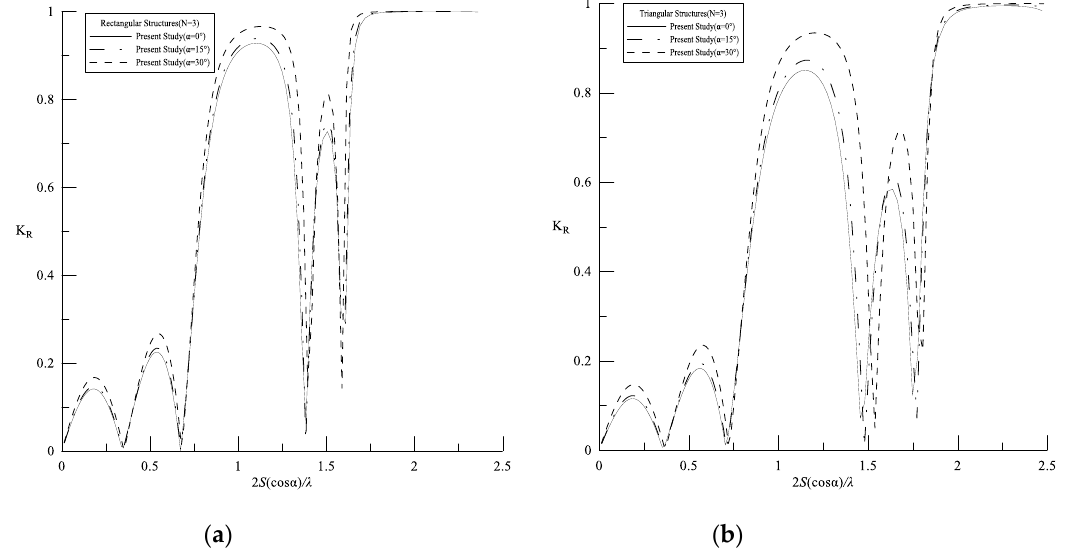
Figure 11. The reflection coefficients with different incidence angles for Bragg reflections by periodic ( a ) rectangular and ( b ) triangular surface-piercing structures over flat bottoms.